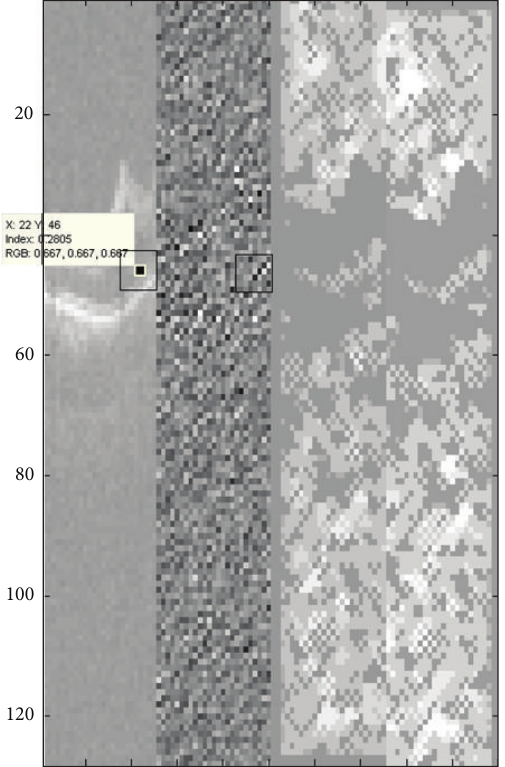
Figure 8: From left to right: imaginary LL subband of one slice of OCT data, the oriented (imaginary) subband around 45 ∘ (225 ∘ ), ℎ + (⋅,45 ∘ ) for LL subband, and ℎ + (⋅,225 ∘ ) for LL subband extracted by applying LPA-ICI to the LL subband of imaginary part of DCWT. As indicated in the second image for 𝑝 1 = (46, 20) , 𝑝 2 = (47, 21) , and 𝑝 3 = (46, 22) we would have ℎ + (𝑝 1 ,45 ∘ ) = 2 , ℎ + (𝑝 1 , 225 ∘ ) = 3 (green dash), ℎ + (𝑝 2 , 45 ∘ ) = 1 , ℎ + (𝑝 2 ,225 ∘ ) = 3 (orange dash), and ,45 ∘ ) = 3 , ℎ + (𝑝 , 225 ∘ ) = 3 (red ℎ + (𝑝 3 3